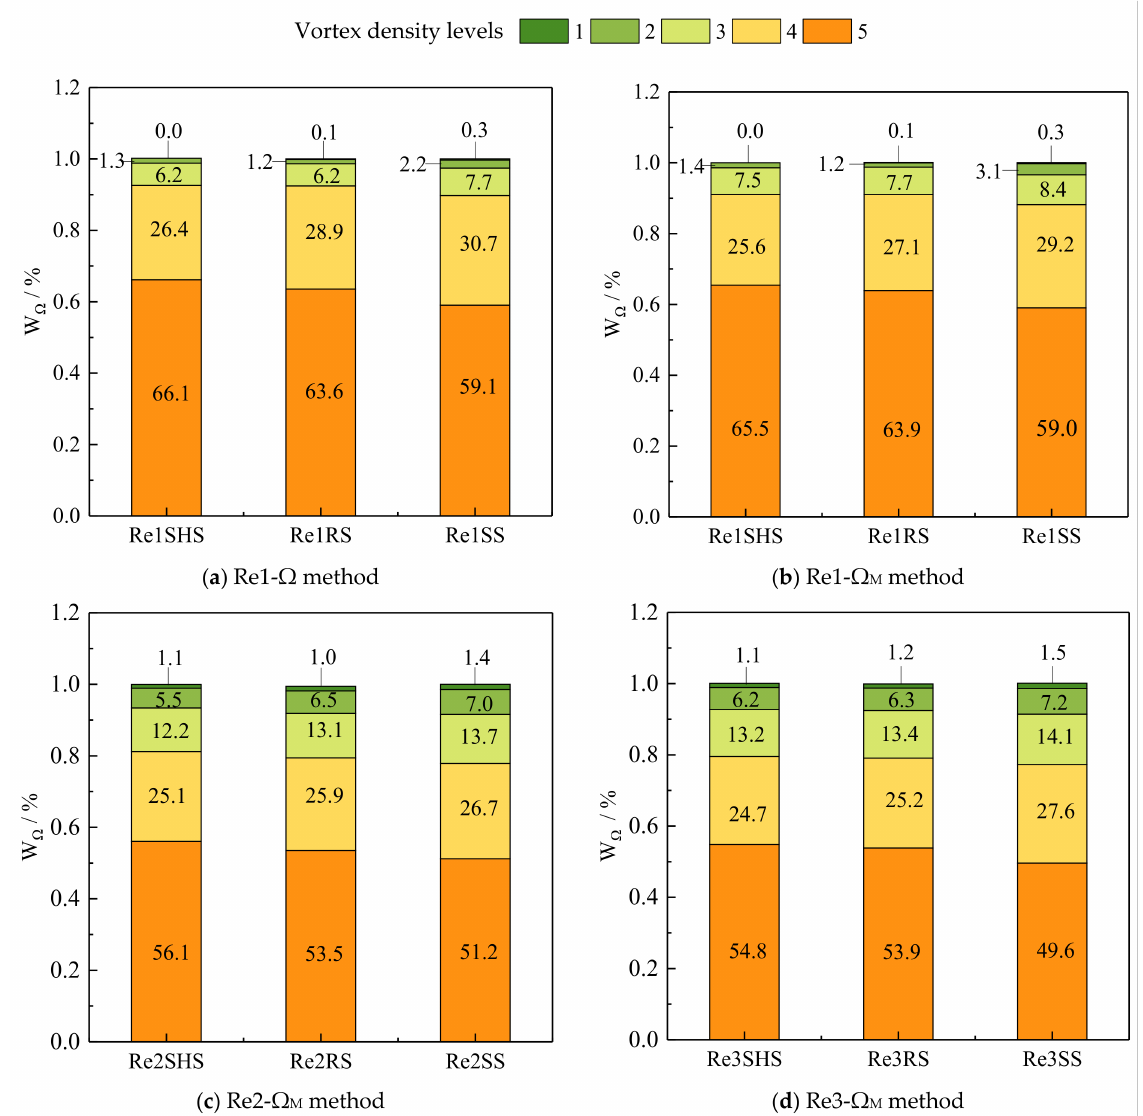
Figure 8. Vortex density near microstructured surfaces at different Reynolds numbers. Note: Re1, Re2, and Re3 are the Reynolds numbers of 85,900, 120,260, and 137,440, respectively. SHS, RS, and SS are the superhydrophobic surface, the riblet surface, and the smooth surface,